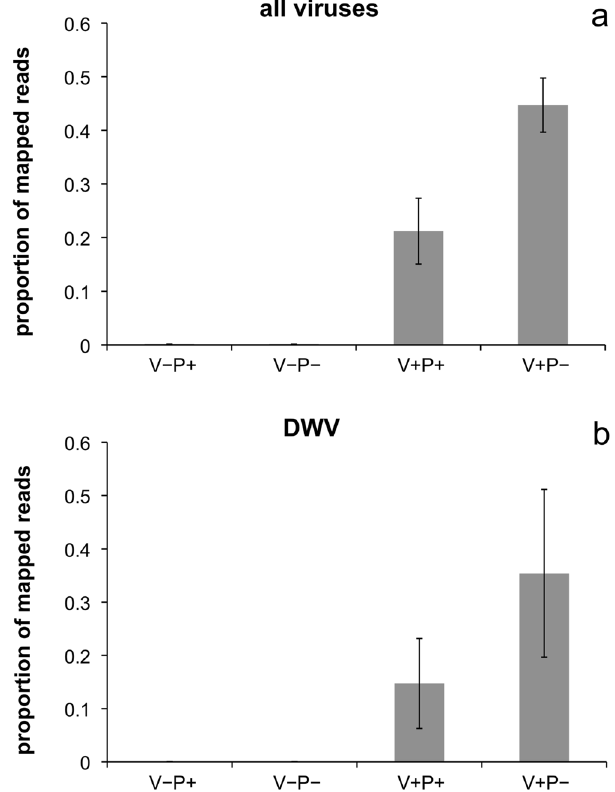
Figure 6. Proportion of mapped reads, in uninfested and Varroa mite infested bees (V − and V + , respectively) according to the diet (P − = sucrose only, P + = sucrose and pollen), related to the 11 most common viruses typically found in the hive ( a ) and to the Deformed Wing Virus ( b